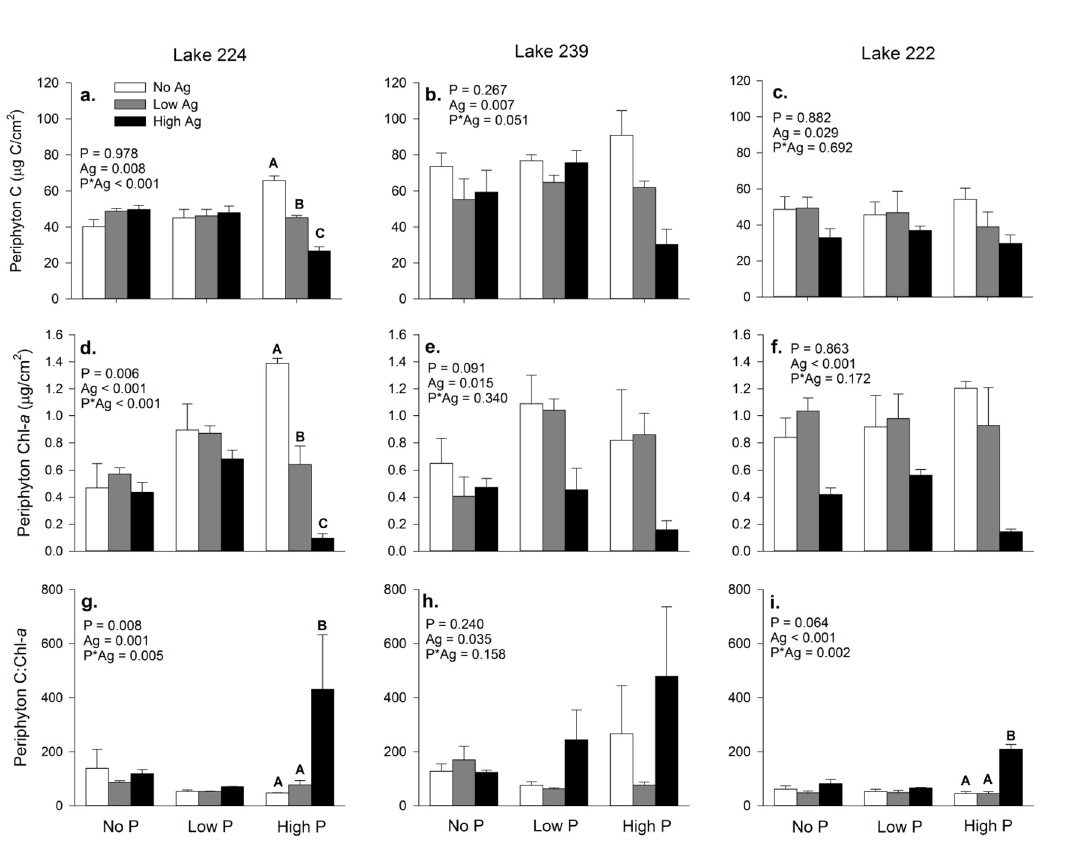
Fig 1. Periphyton C, Chl- a and autotrophic index from all three lakes. Bars are means of three substrates with standard error whiskers. p values for main and interactive effects (2-way ANOVA) are presented in each panel. For variables with a significant P * Ag interaction, different capital letters indicate significantly different means among AgNP treatments within the same P treatment as determined by Tukey pairwise